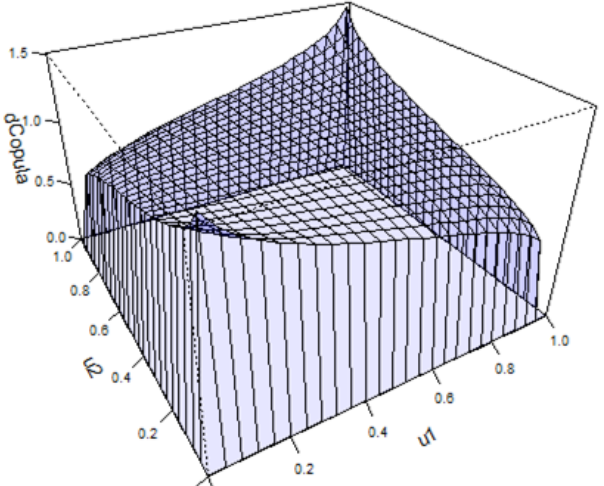
Figure 6. The estimated Gaussian copula.